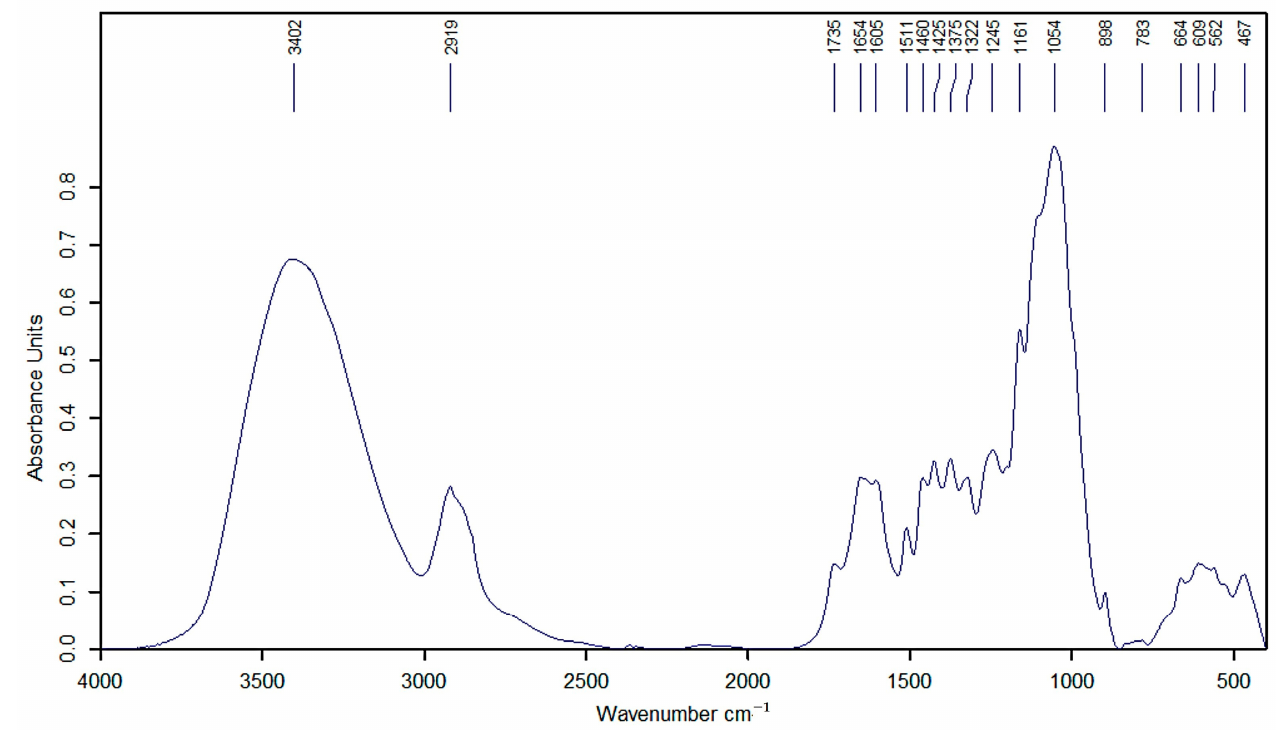
Figure 7. FT-IR spectrum of wheat straw powder .